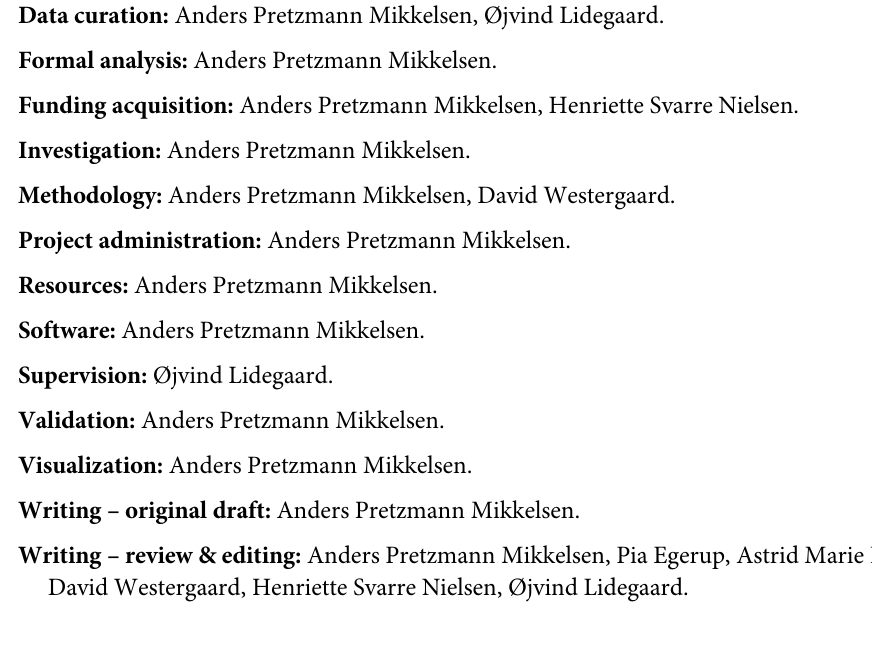
S2 Table. Data used to create Fig 1. S3 Table. Association of pregnancy loss with multiple sclerosis, further adjusted for smok- ing status defined by hospital admission for smoking (ICD-10: F17) or fulfilling prescrip- tion for a smoking cessation drug (ATC: